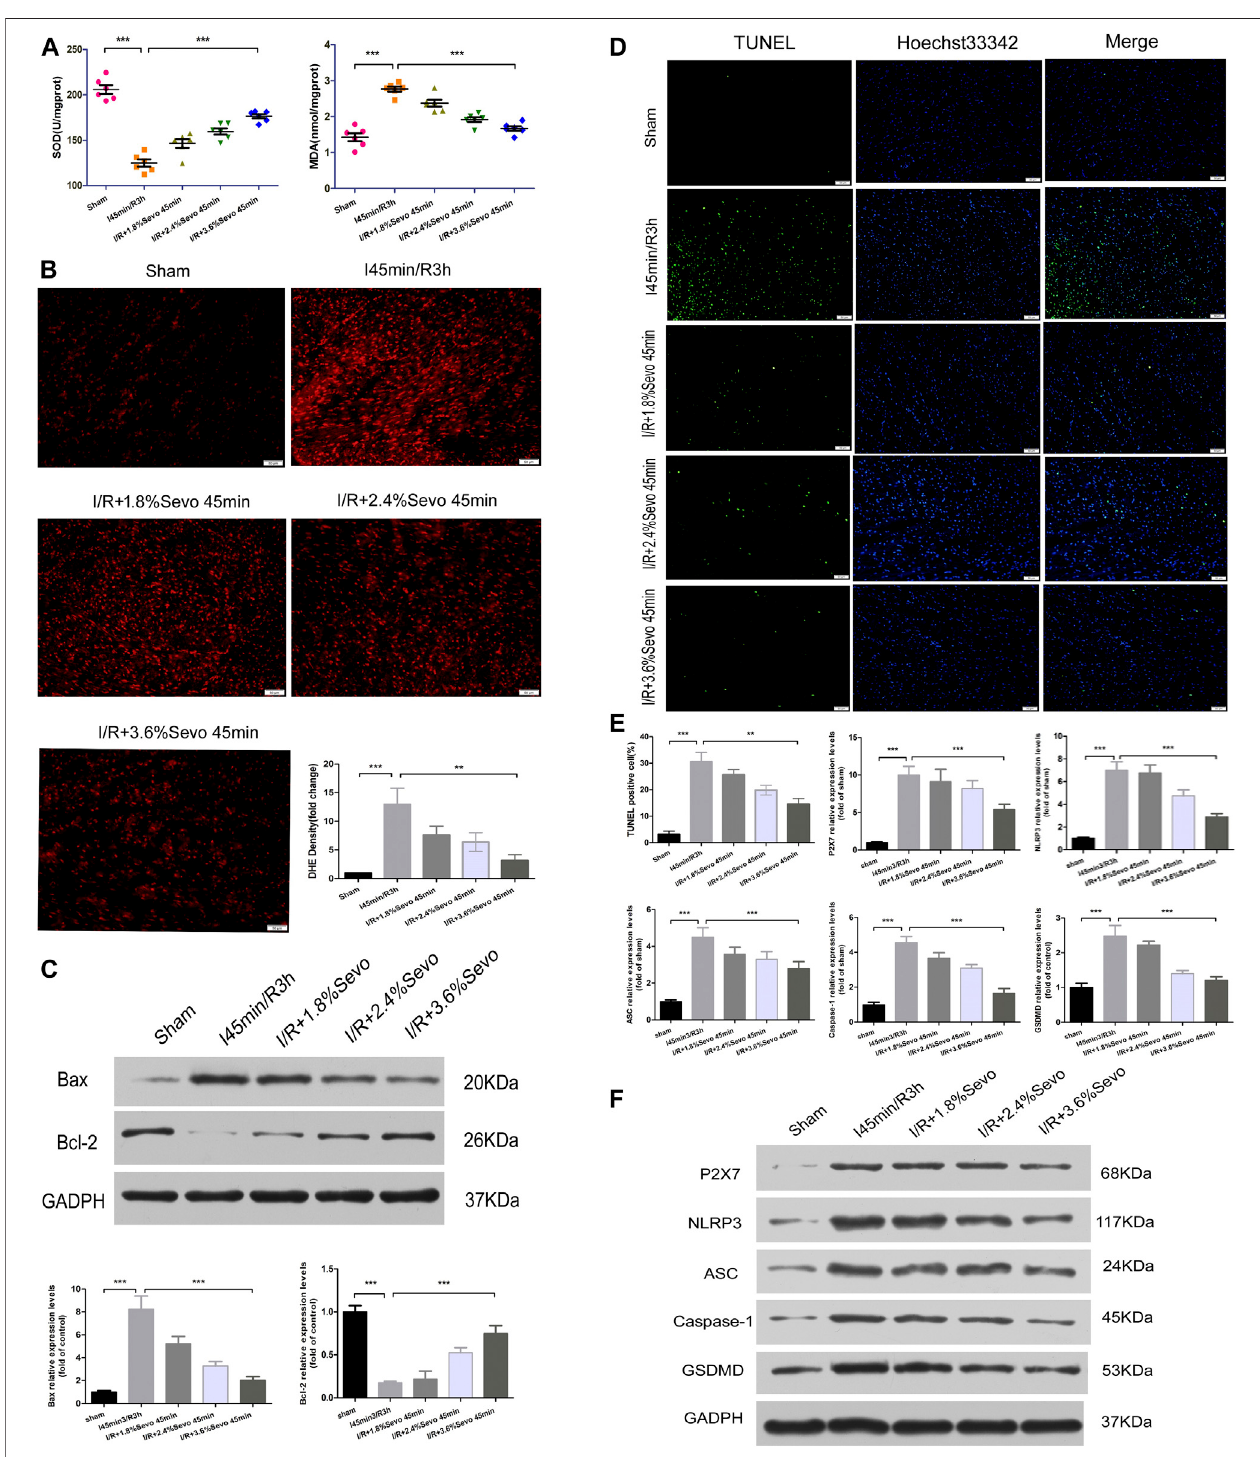
FIGURE 5 | Sevo fl urane alleviates oxidative stress and pyroptosis in MIRI rats (A) Effects of different concentrations of Sevo fl urane on the expression of MDA and SOD in myocardial tissue after ischemia reperfusion. All values are expressed as means ± SD (n (cid:1) 6). * p < 0.05, ** p < 0.01, *** p < 0.001 vs respective controls (B) ROS FluorescentProbe-DHE.Sevo fl uraneincreasedATPcontent,stabilizedmembrane potential,andreducedROSproduction(n (cid:1) 6,Scalebars50 um) (C) TheExpression of apoptosis-related proteins Bax and Bcl-2.Data are expressed relative to the mean value for sham group and were presented as mean ± SD (n (cid:1) 6). * p < 0.05, ** p < 0.01, *** p < 0.001 vs respective controls (D) Effects of different concentrations of Sevo fl urane on the TUNEL staining in myocardial tissue after MIRI. All values are expressed as means ± SD (n (cid:1) 6). * p < 0.05, ** p < 0.01, *** p < 0.001 vs respective controls. Scale bars 50 um (E) Histogram of TUNEL and the protein expression of P2X7, NLRP3, ASC, Caspase-1 and GSDMD (F) Immunoblotting measured the levels of P2X7, NLRP3, ASC, Caspase-1 and GSDMD protein expression. Data are expressed relative to the mean value for control group and were presented as mean ± SD (n (cid:1) 6). * p < 0.05, ** p < 0.01, *** p < 0.001 vs respective controls.